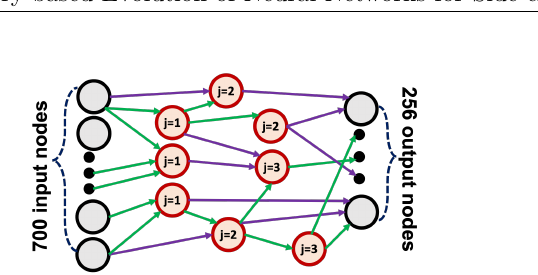
Figure 5: Example of the irregular InfoNEAT architecture used for SCA with 5 layers (3 hidden layers based on the node connections). The nodes in one layer can have a direct connection to a layer other than the immediate next layer (as highlighted in purple), e.g., the top input node has a direct connection to a node in hidden layer j = 2, but not j = 1. sub-models that is neither underfitting nor